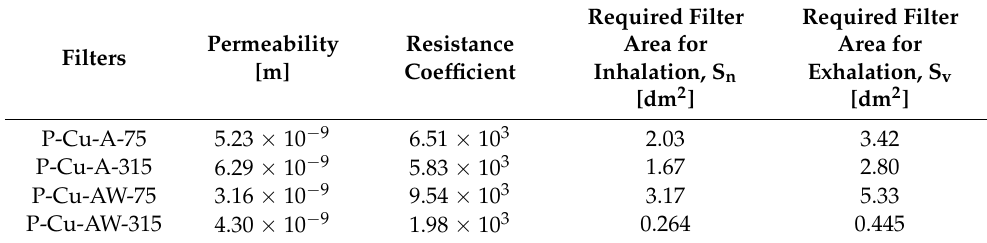
The permeability, k (cid:48) f , and the resistance coefficient, β (cid:48) , were determined from each pair of the measured pressure drop values. Based on this, the correlations between the pressure